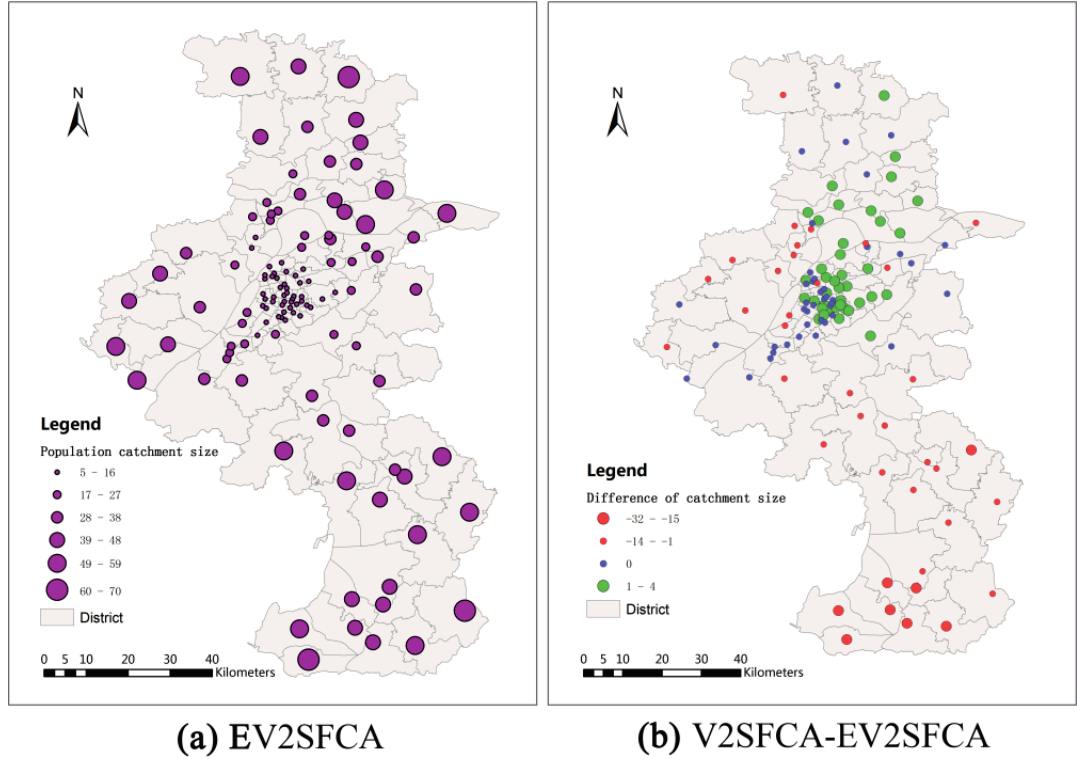
Figure 4. Population catchment sizes calculated by EV2SFCA ( a ) and population catchment size differences between V2SFCA and EV2SFCA methods ( b